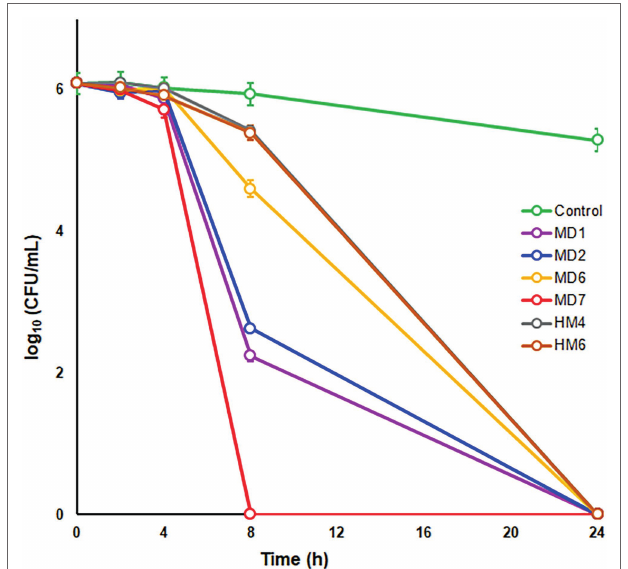
FIGURE 2 | Time–kill kinetics of selected DHP-based HHQ derivatives against Helicobacter pylori strain ATCC 700684. Bacterial counts were determined at time zero and after 2, 4, 8, and 24 h of exposure to two times the MIC of each compound. Mixtures of bacteria with dimethyl sulfoxide (DMSO; vehicle) instead of DHP were used as controls. Values are the averages of six independent determinations; vertical bars represent SDs. Please note that in some instances, the error bar is smaller than the symbols used.